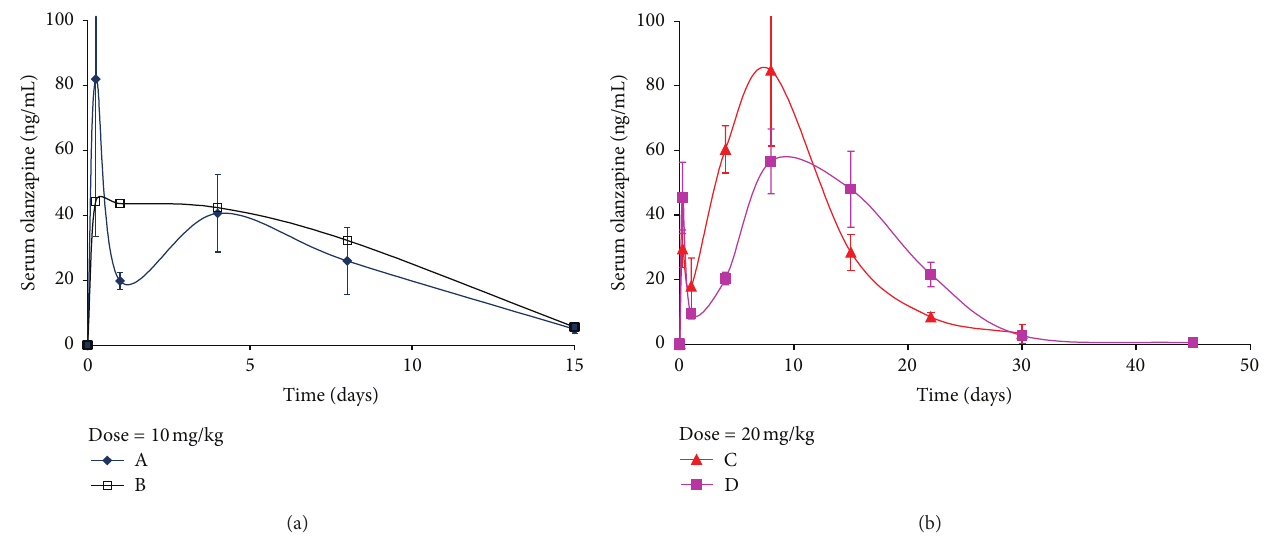
Figure 3: In vivo release of Olanzapine from PLGA microspheres (Formulations A and B = 10 mg/kg dose and Formulations C and D = 20 mg/kg dose) (from [5]).